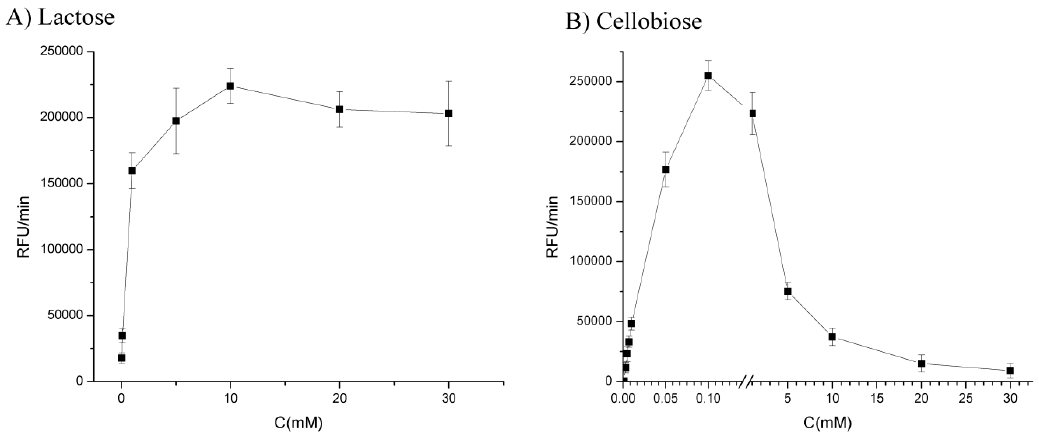
Figure 3. Dependence of fluorescence signal (RFU/min) on ( A ) lactose ( B ) cellobiose concentration in 0.1 M sodium phosphate buffer pH 5.5 with 0.1 mM resazurin and 0.29 IU/mL of CDH enzyme. Fluorescence measured at ex/em 540/590 nm .